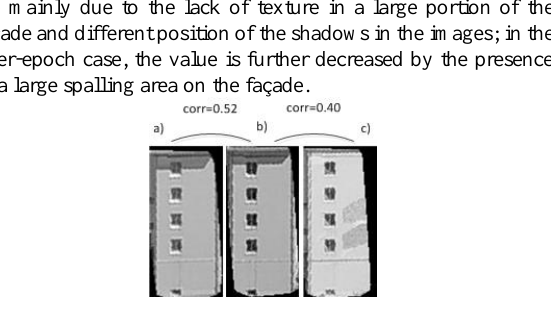
Figure 15. Hazard-related changes. Same façade extracted from both epochs. a) and b) relative to pre-event and c) post event. Not all changes are damage related as can be seen in Figure 16.